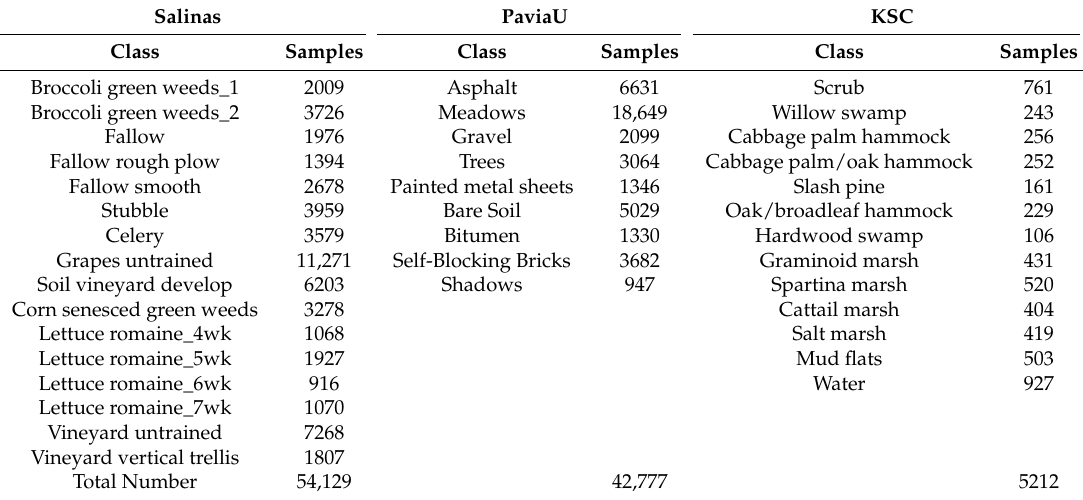
Table 2. Ground-truth classes of the three data